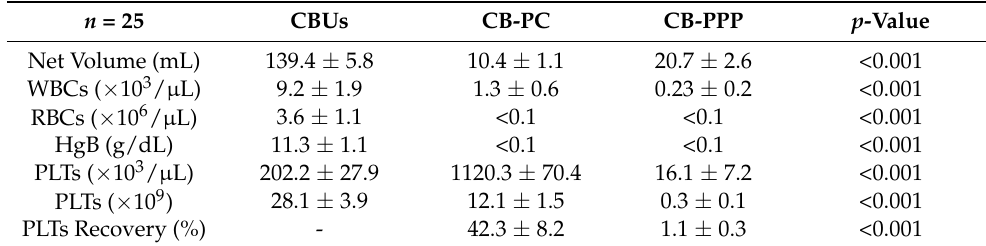
Table 2. Characteristics of CBUs, CB-PC, and CB-PPP. n = 25